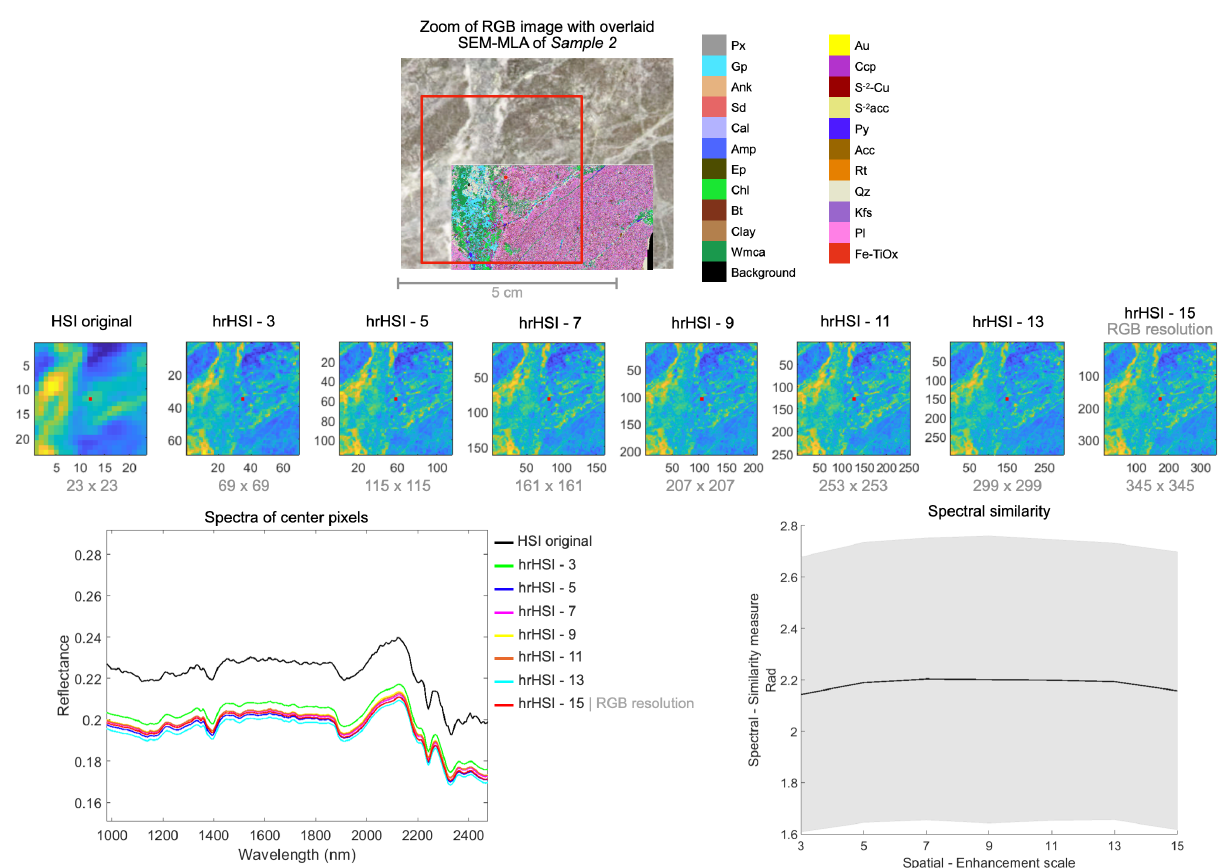
Figure 5. Sensitivity analysis for the spectral integrity by means of SAM measurement for a small section of Sample 2 . Top image shows an RGB image of the small section, and the red square shows the area where the analysis was performed. Below are images of band 889 nm of the hyperspectral (HSI) data enhanced at different factors with an overlaid red dot pointing toward the center pixel. At the bottom, from left to right, is the spectra of the center pixels and the plot with